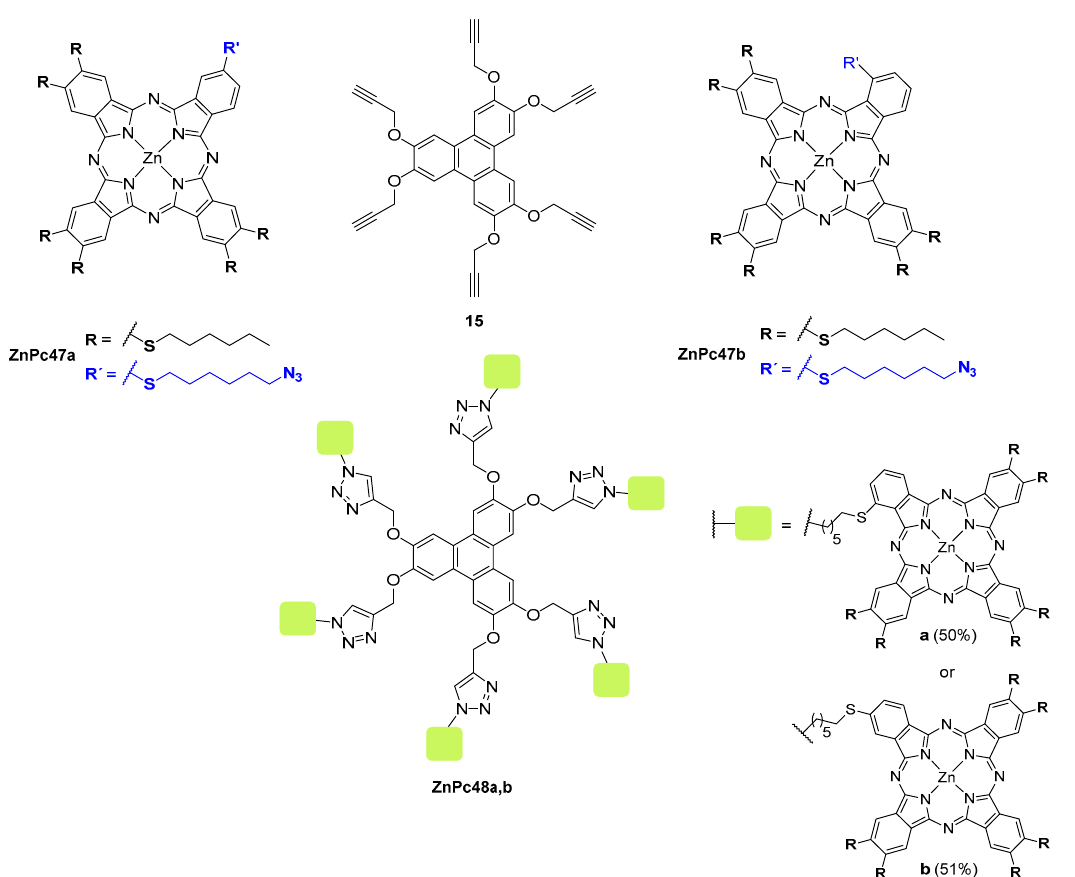
Figure 7. Structures of the compounds used in the preparation of the Pc derivatives ZnPc48a , b .